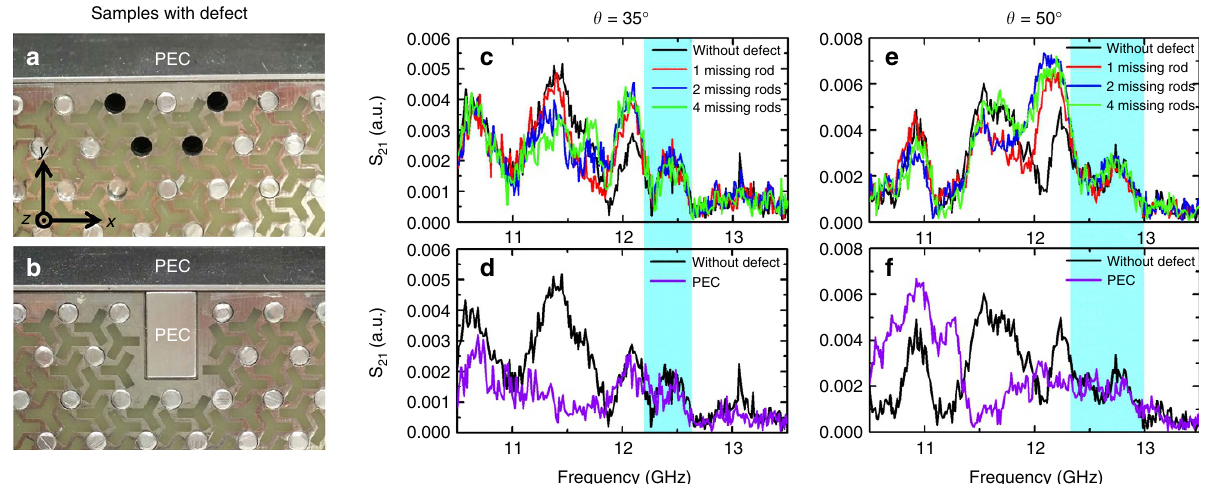
Figure 9 | Measured surface transmissions when different kinds of defects are introduced near the surface. ( a , b ) Photograph of the samples with defects. ( c , d ) Measured transmission spectra for two kinds of defects when the incident angle y ¼ 35 (cid:2) ( k z ¼ 0.2581 p / d for 12.5GHz). ( e ), ( f ) Results for y ¼ 50 (cid:2) ( k z ¼ 0.3447 p / d for 12.5GHz). Cyan boxes in c – f highlight the frequency region of k z -preserved one-way surface states where no obvious backscattering is introduced by the two kinds of defects. Note that the frequency region of robust transport for y ¼ 50 (cid:2) is wider than that for y ¼ 35 (cid:2) . This is consistent with the fact that the nontrivial band gap in the reduced 2D Brillouin zone is wider for a larger k z